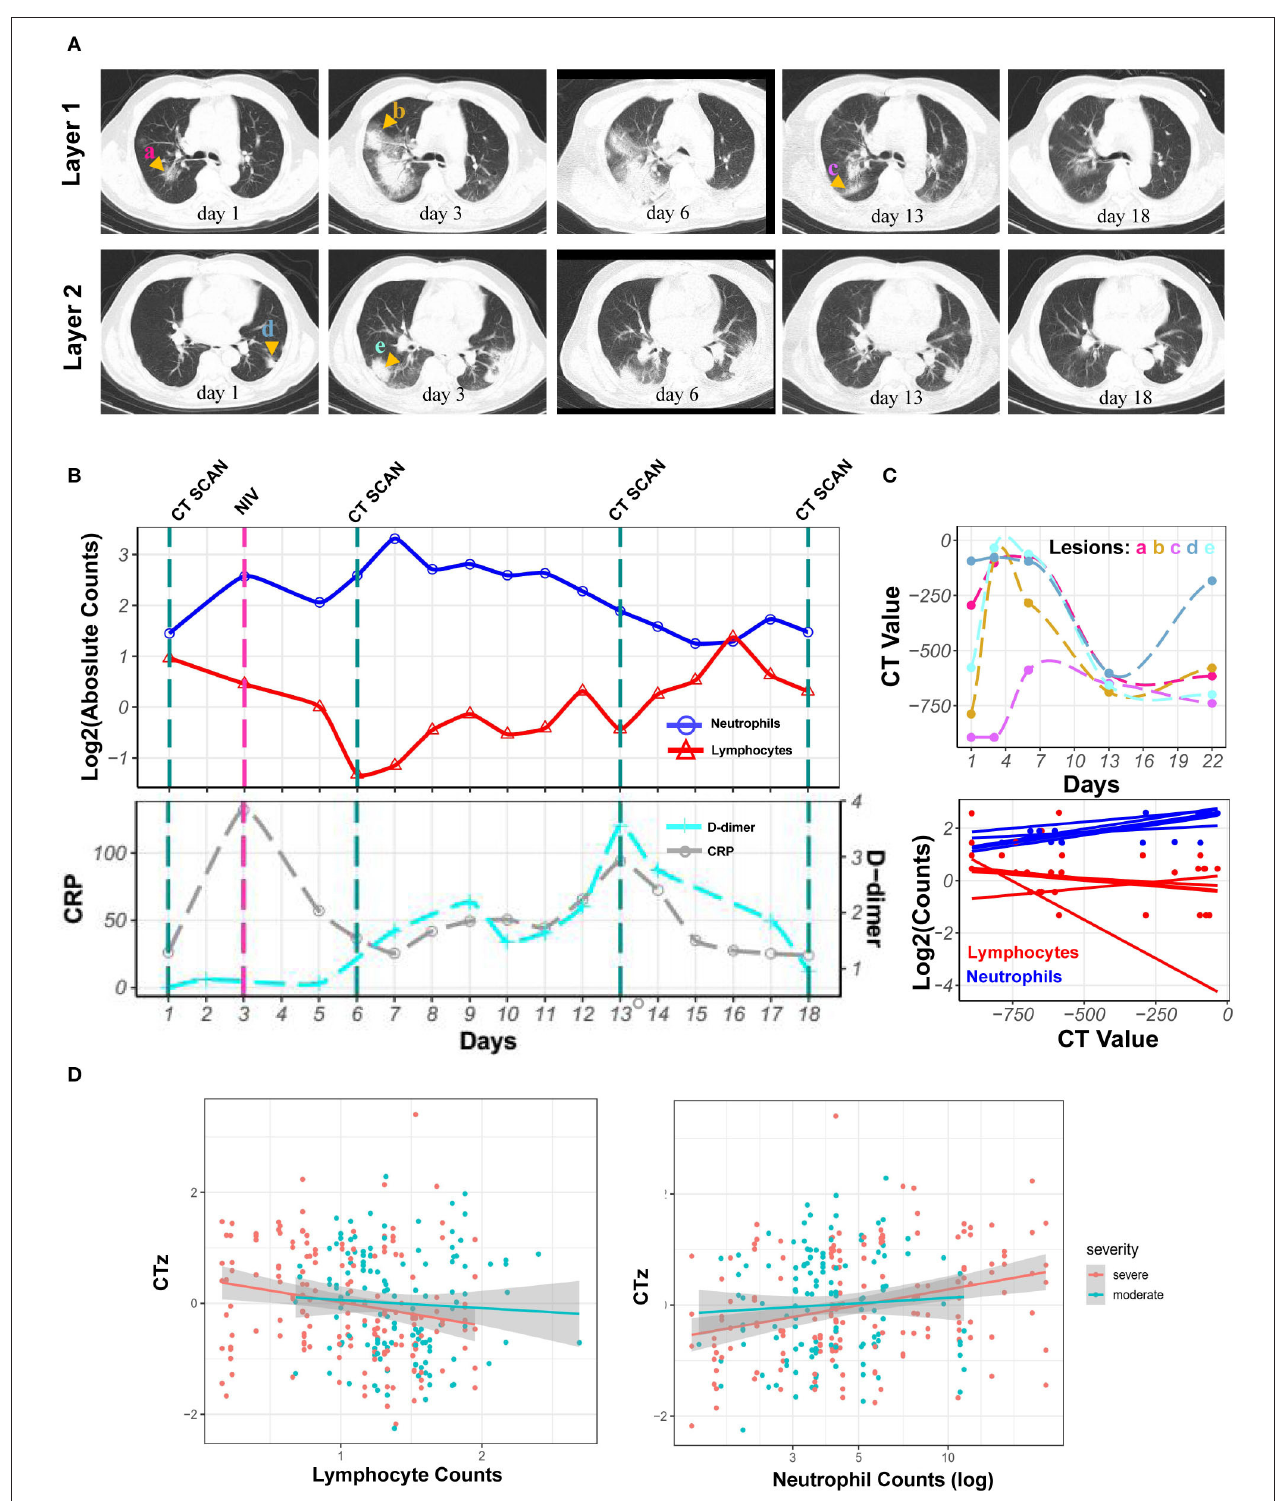
FIGURE 3 | Kinetics of laboratory parameters and serial chest CT images of severe COVID-19 patient with the development of neutrophilia. (A) Normal chest CT with axial planes at indicated time point. (B) The dynamics of neutrophil counts (blue line), lymphocyte counts (red line) with log 2 scaling, and CRP (gray line) and D-dimer (cyan line) levels at indicated time point. (C) CT value of lesions and its correlation with log 2 scaled neutrophil and lymphocyte counts at indicated time point. (D) Least-square fits of linear models to summarize the z-values of CT values as a function of log-transformed neutrophil counts for 23 patients. Points are pairs of CTz values ( z -values of individual CT measurements) and log-neutrophil counts, colored according to severity of COVID-19. Colored lines are the corresponding least-square fits to the data form each severity group. Gray areas are 95% confidence intervals.